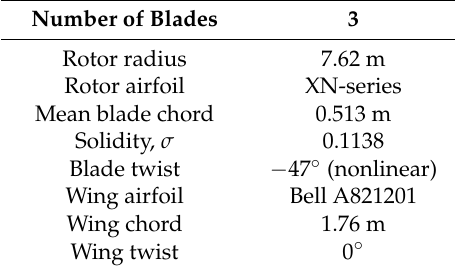
Table 1. Geometric details of the 0.658-scale V-22 model [5].